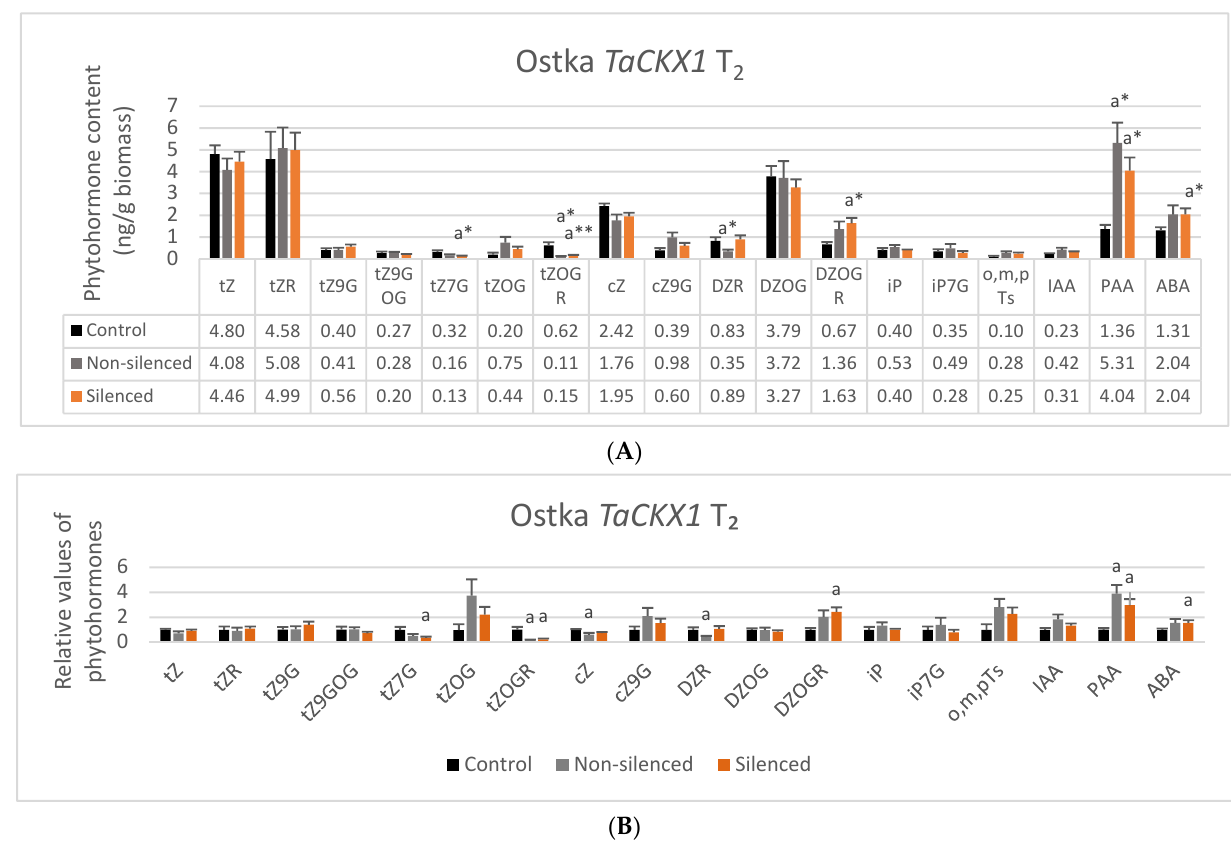
Figure 3. Phytohormone content ( A ) and their relative values ( B ) in control (black bars), nonsilenced (grey bars) and silenced (orange bars) TaCKX1 , T 2 lines. Trace amounts (<0.2 ng/g biomass): cZOGR, iPR, o,pTs, BA. Not detected: cZOG, cZR, DZ, DZ9G, DZ7G, IBA, IPA, GA. Error bars denote ± SE. Significant differences between control and nonsilenced or control and silenced lines (a): * significant at p ≤ 0.05; ** significant at p ≤ 0.01. No significant difference between nonsilenced and silenced lines.